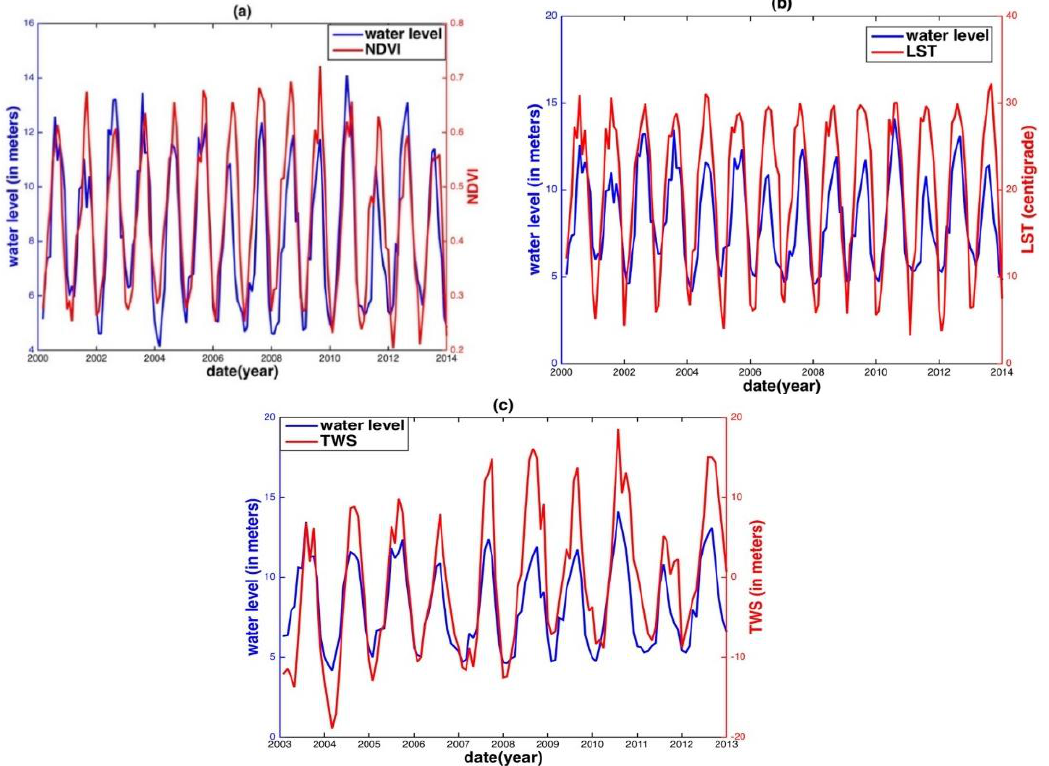
Figure 3. Comparison of the time series of monthly-averaged water levels recorded at Datong (blue) station and ( a ) NDVI; ( b ) LST and ( c ) TWS.